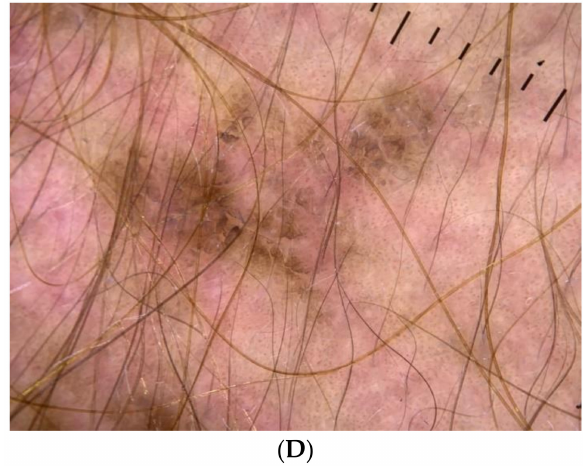
Figure 1. ( A ) A 19-year-old female with obesity and PCOS who presented with neck AN, ( B ) Intermammary and inframammary AN, ( C ) Antecubital fossa hyperpigmented AN lesions; ( D ) Dermoscopy image of AN lesions in the same patient—hyperpigmented dots accompanied by crista cutis and sulci cutis on a papillomatous